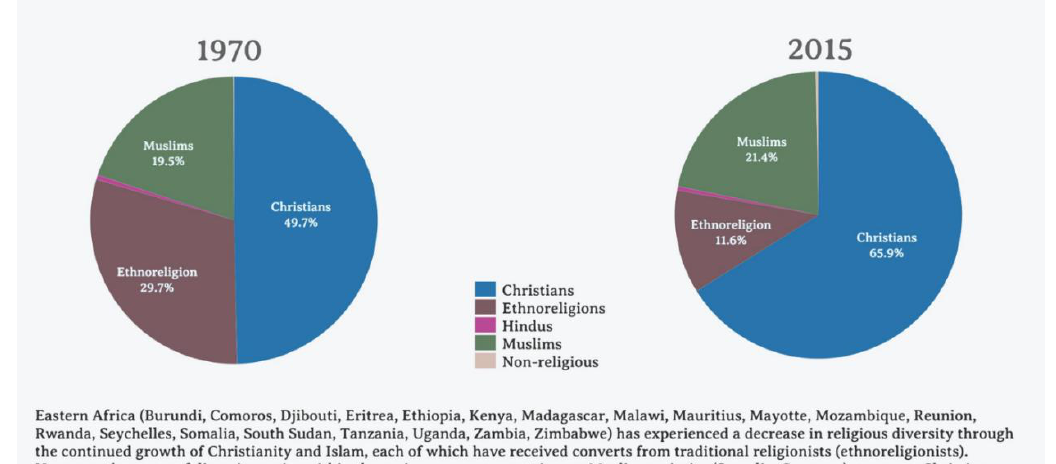
Figure 6. Religious diversity in the Middle East, 1970 and 2015.